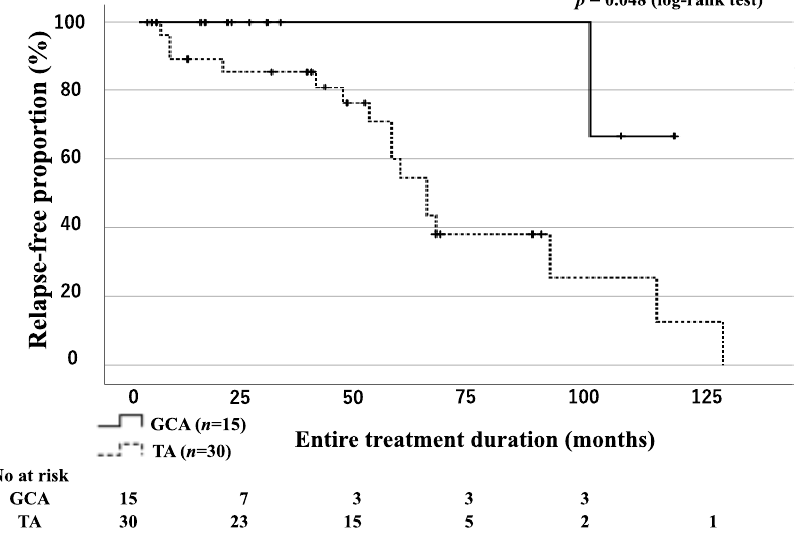
Figure 3. Relapse-free survival of patients with GCA and TA. Kaplan–Meier curves show relapse-free survival in patients with GCA ( n = 15) and TA ( n = 30). The starting point (0 months) was the date of the initiation of remission induction therapy. A significant difference was observed between the GCA and TA